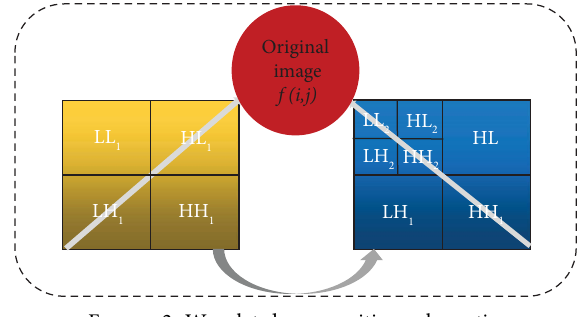
Figure 2: Wavelet decomposition